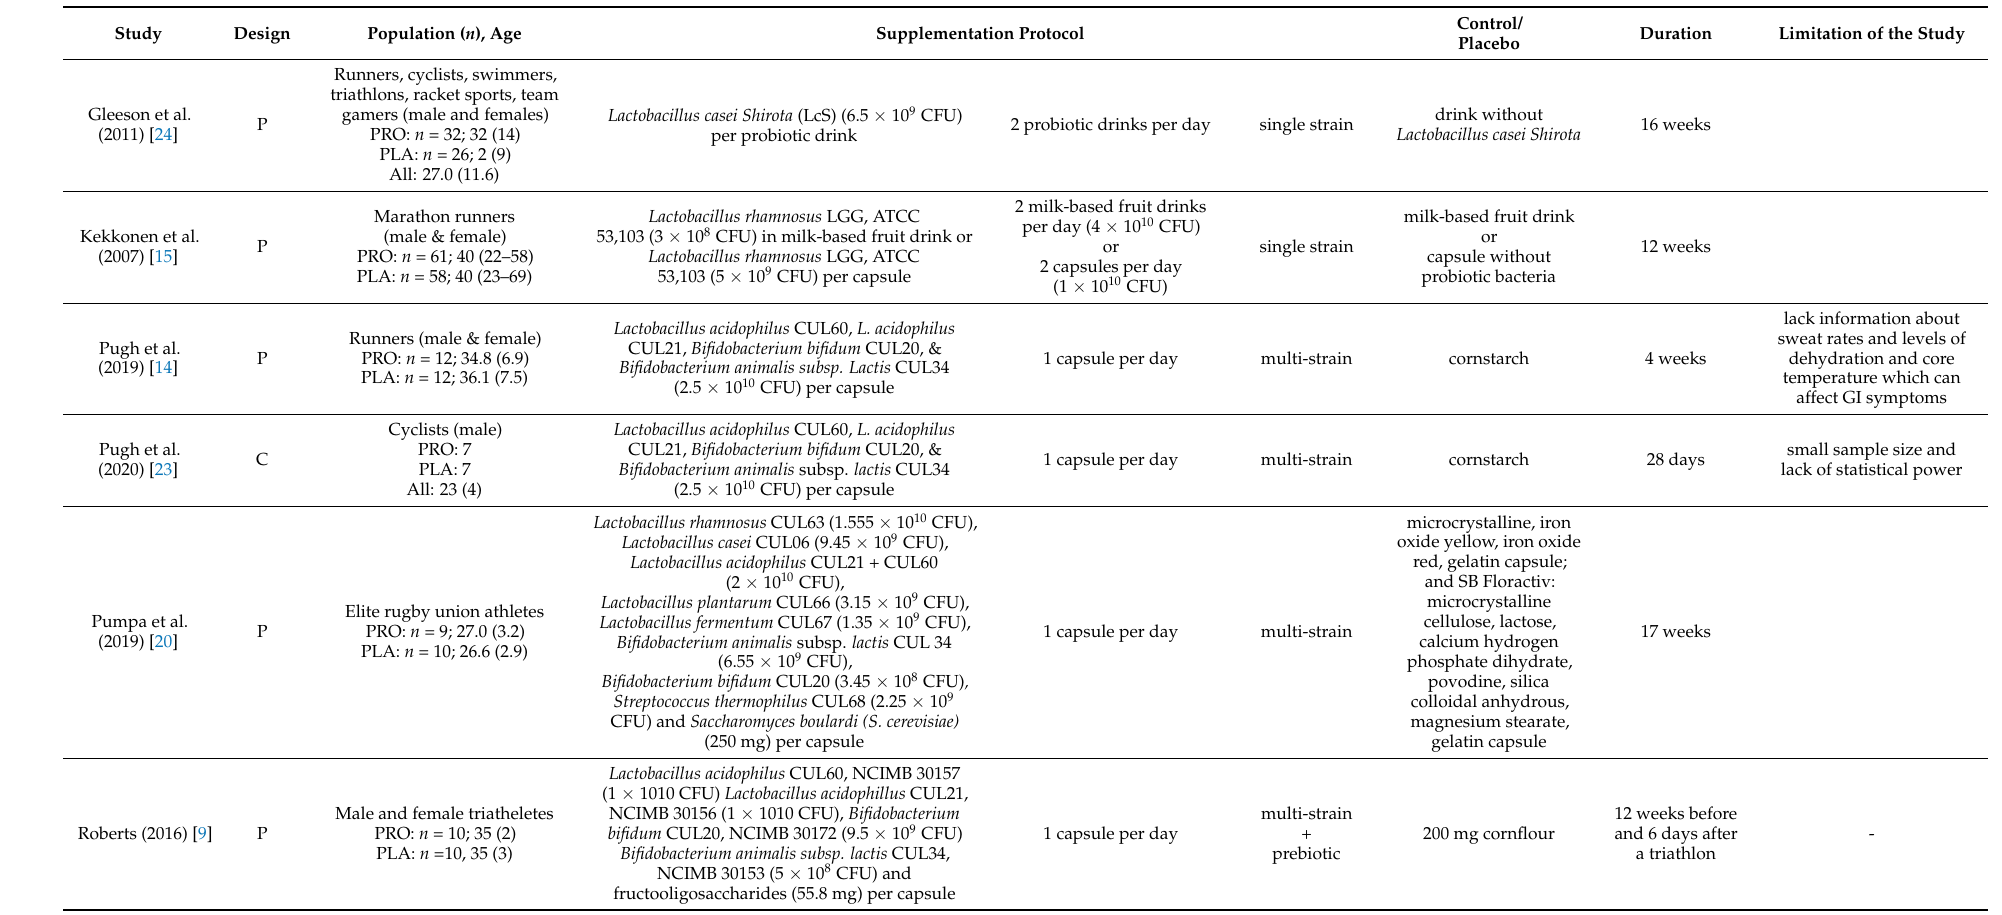
Table 2. Characteristics of studies and